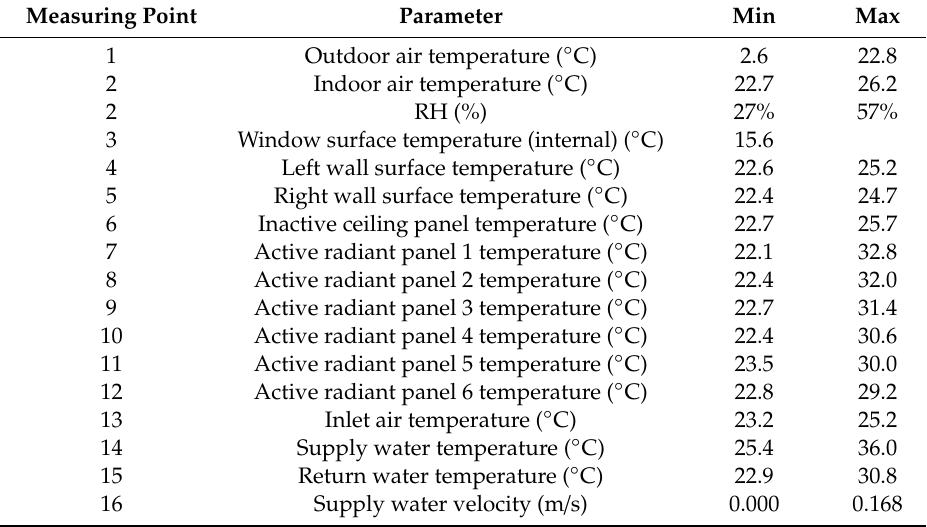
Table 2. In situ measurements from 2 February to 9 February